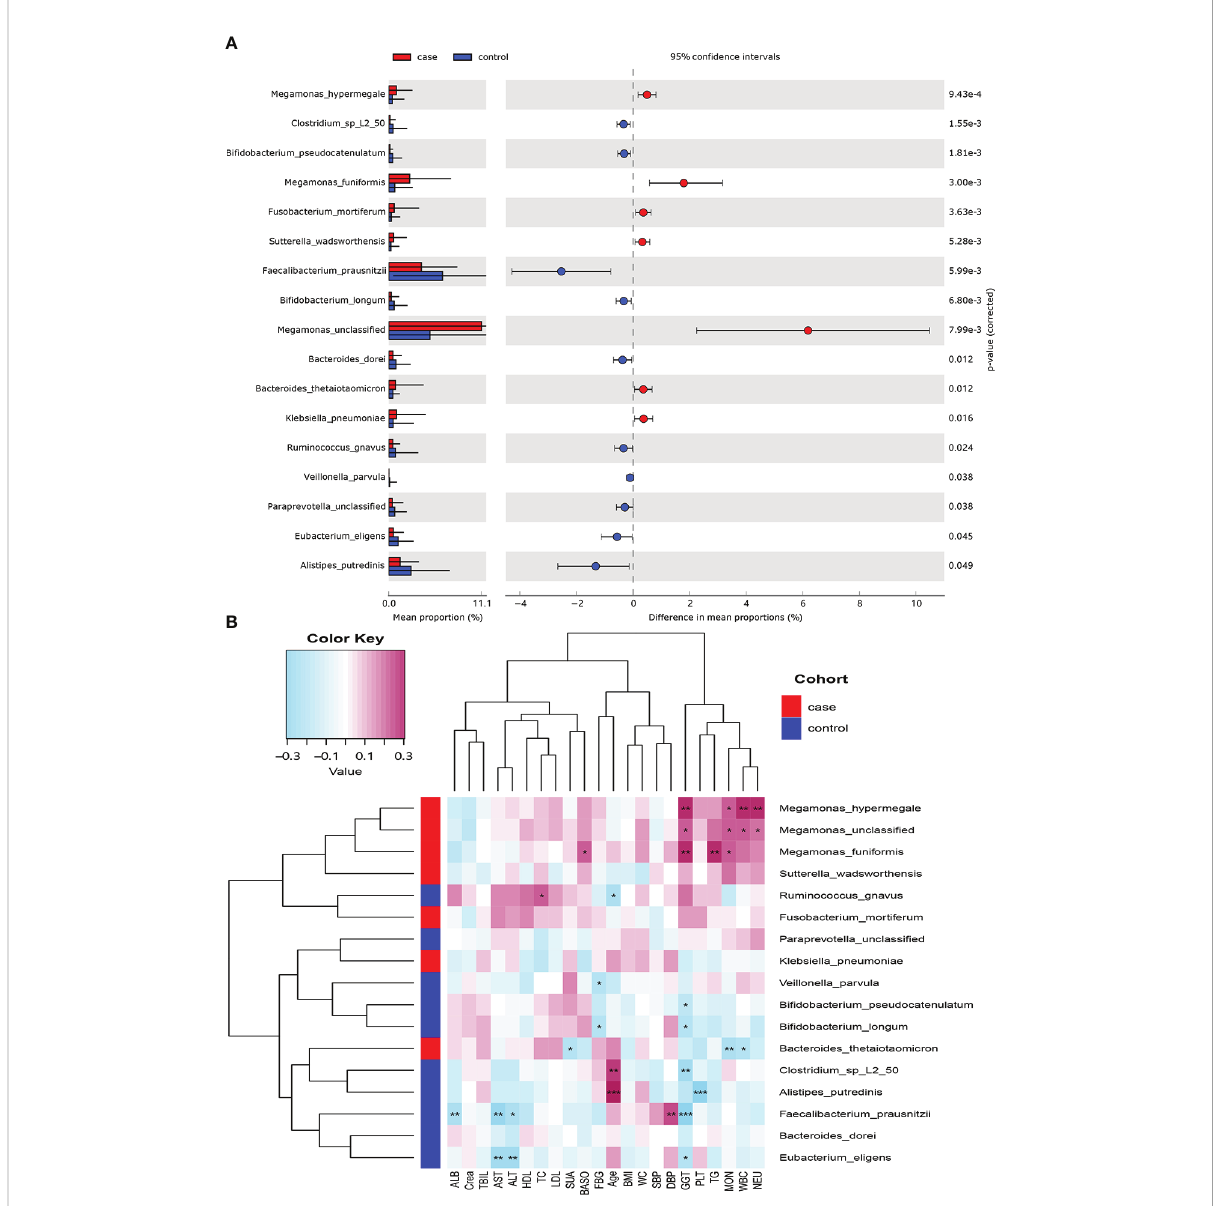
FIGURE 3 Microbiome difference between the case and control groups and the correlation with clinical index ( P-value corrected< 0.05). (A) The relative abundance of bacterial species with signi fi cant difference between the two groups. (B) Correlation matrix of the bacterial species and clinical index. Blue cell color represented a negative correlation; red cell color represented a positive correlation. * P < 0.05, ** P < 0.01, and *** P <